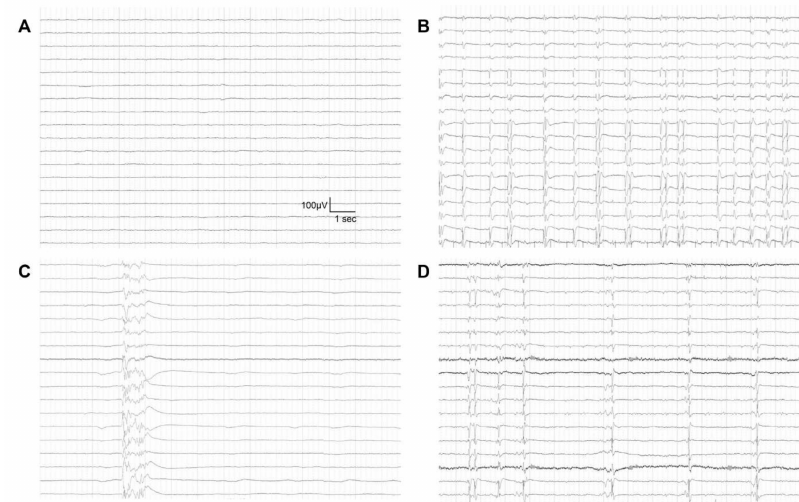
Figure 2. Highly malignant patterns of electroencephalography in patients after extracorporeal cardiopulmonary resuscitation. ( A ) Suppressed background without discharges; ( B ) Suppressed background with superimposed continuous periodic discharges; ( C ) burst-suppression without discharges; and ( D ) burst-suppression with superimposed